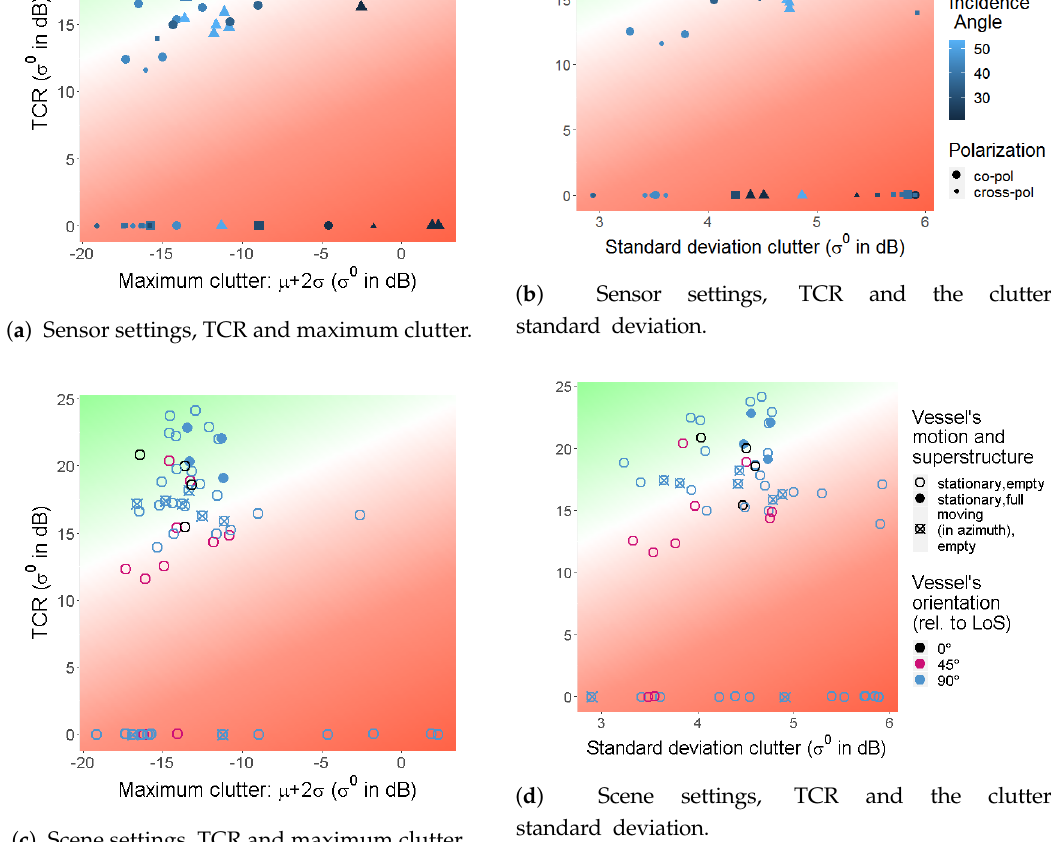
Figure 17. Influences of selected scene settings and sensor settings on the TCR with respect to the water surface’s clutter